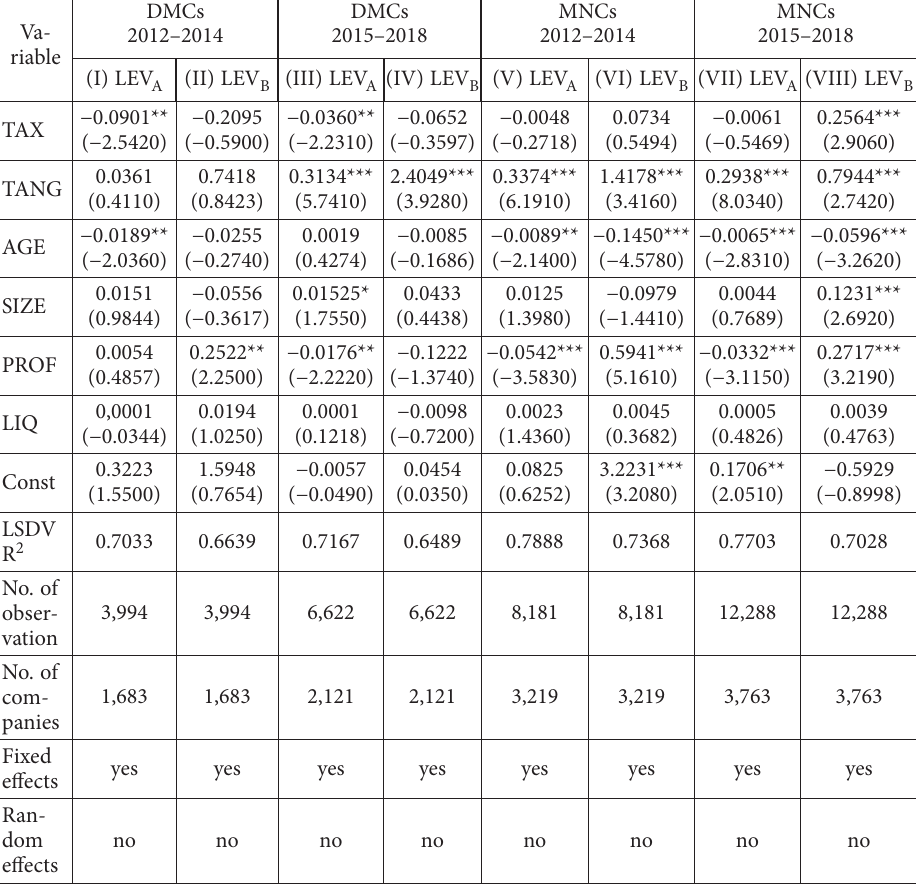
Table 11. Regression results 2012–2014 and 2015–2018